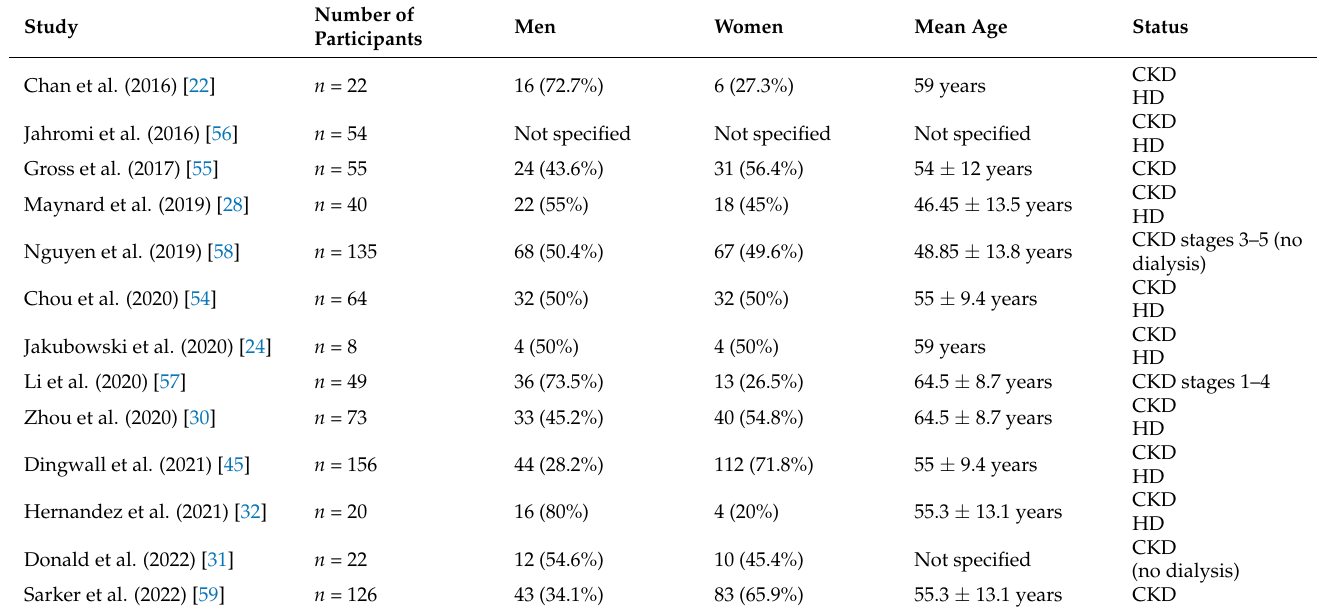
Abbreviations: CKD (Chronic Kidney Disease); HD (Hemodialysis).